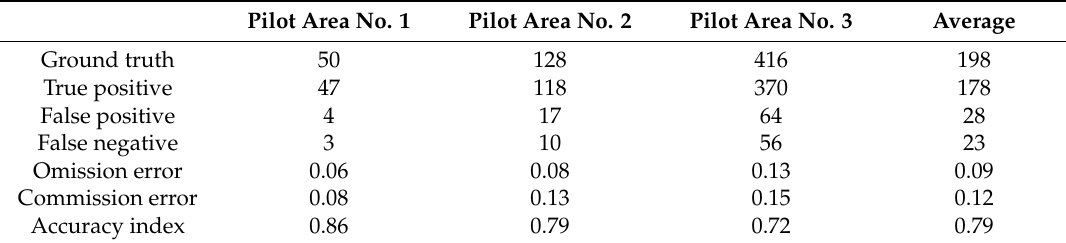
Table 1. Accuracy assessment of the ANFIS-wavelet method for the three pilot study areas: No. 1, No. 2 and No. 3, with low, moderate and high complexity, respectively.